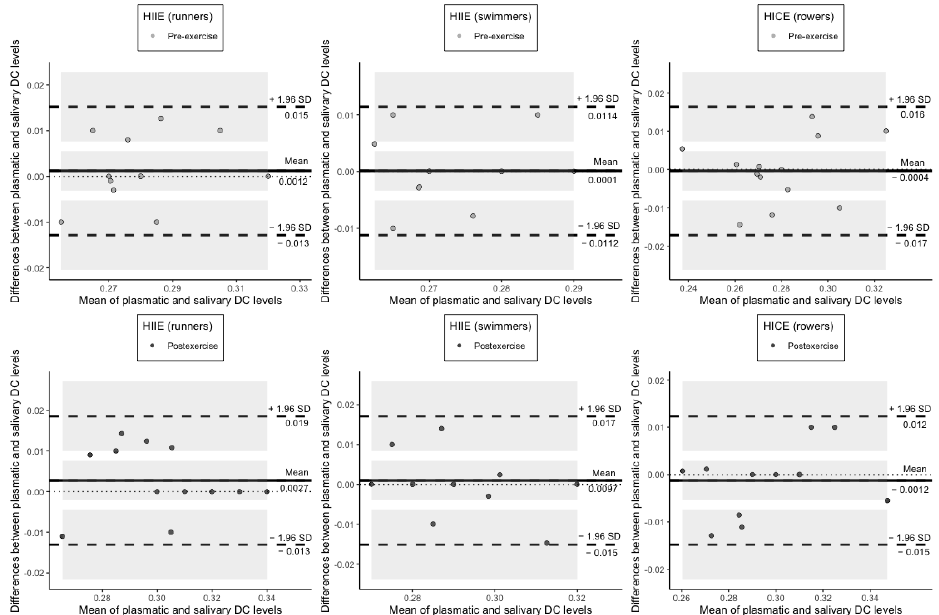
Figure 3. Plots of difference between the measurements of DC levels in plasma and saliva vs. the mean of the measurement. The bias (mean difference) is represented by a solid line parallel to the X axis. The limits of agreement are represented by the dashed lines parallel to the X axis at − 1.96 and +1.96 SD. Shaded areas present confidence interval limits for mean and agreement limits. DC: diene conjugates; HIIE: high-intensity interval exercise; HICE: high-intensity continuous exercise; SD: standard deviation.